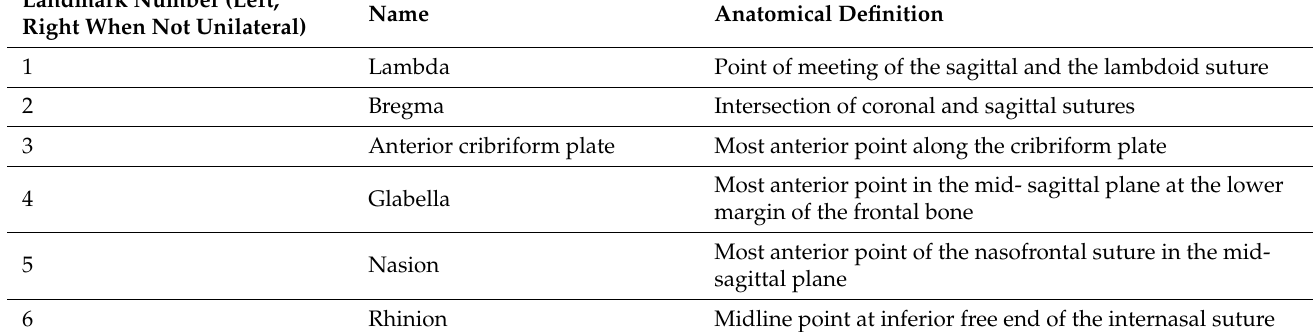
Table A2. Landmark configuration and relative anatomical